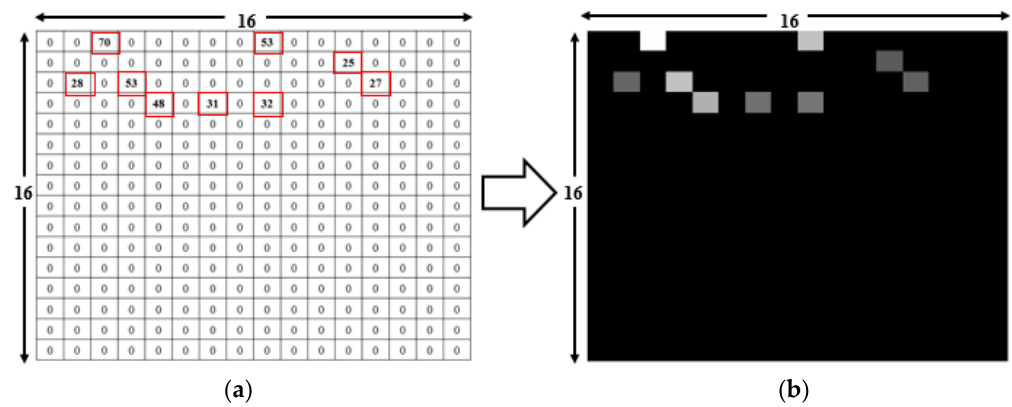
Figure 5. Deep learning input file conversion from a CSV file to an image. ( a ) Input CSV readings of the nine visible RSSIs from a total of 256 APs. ( b ) Converted grayscale image with nine bright spots representing APs visible at the RP.